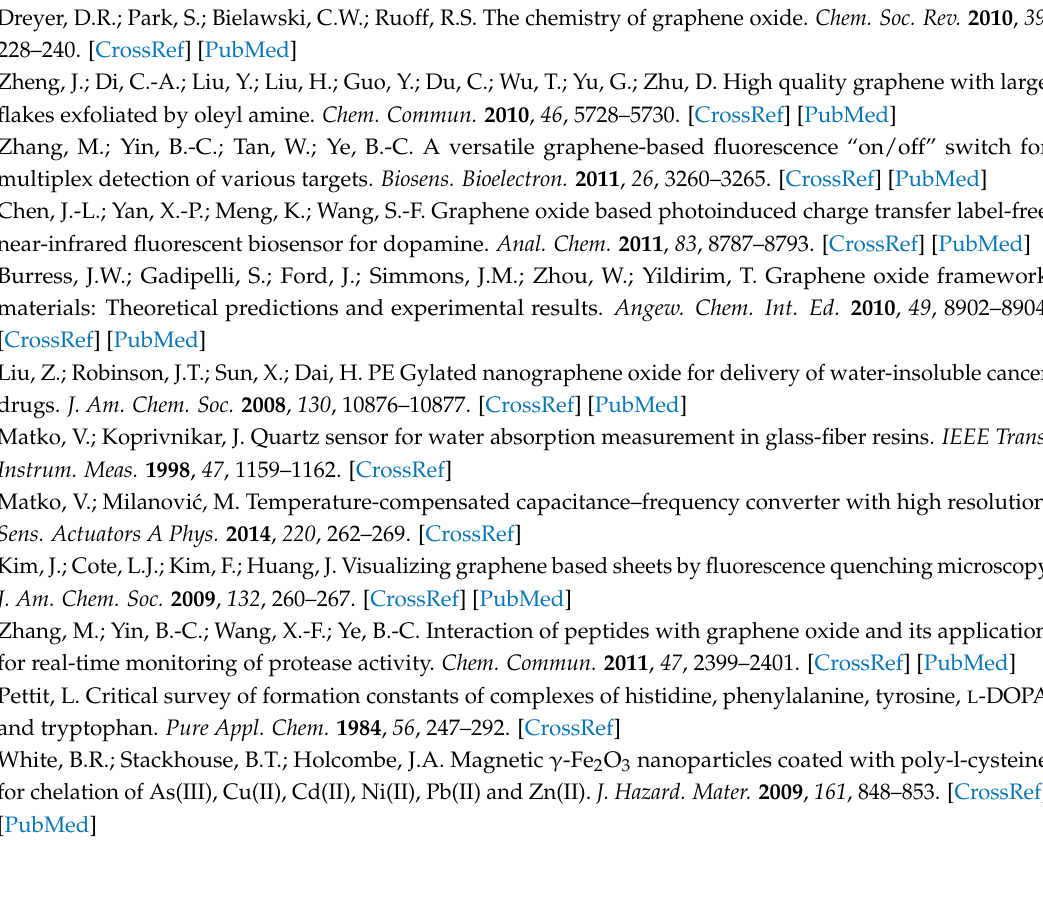
Figure S1: TEM image of single layer graphene (ACS Material-Graphene Factory), Figure S2: SEM image of single layer graphene (ACS Material-Graphene Factory), Figure S3: HRTEM image of single layer graphene (ACS Material-Graphene Factory), Figure S4: XRD patterns of single layer graphene (ACS Material-Graphene Factory), Figure S5: XPS patterns of single layer graphene (ACS Material-Graphene Factory), Figure S6: Raman spectrum of single layer graphene (ACS Material-Graphene